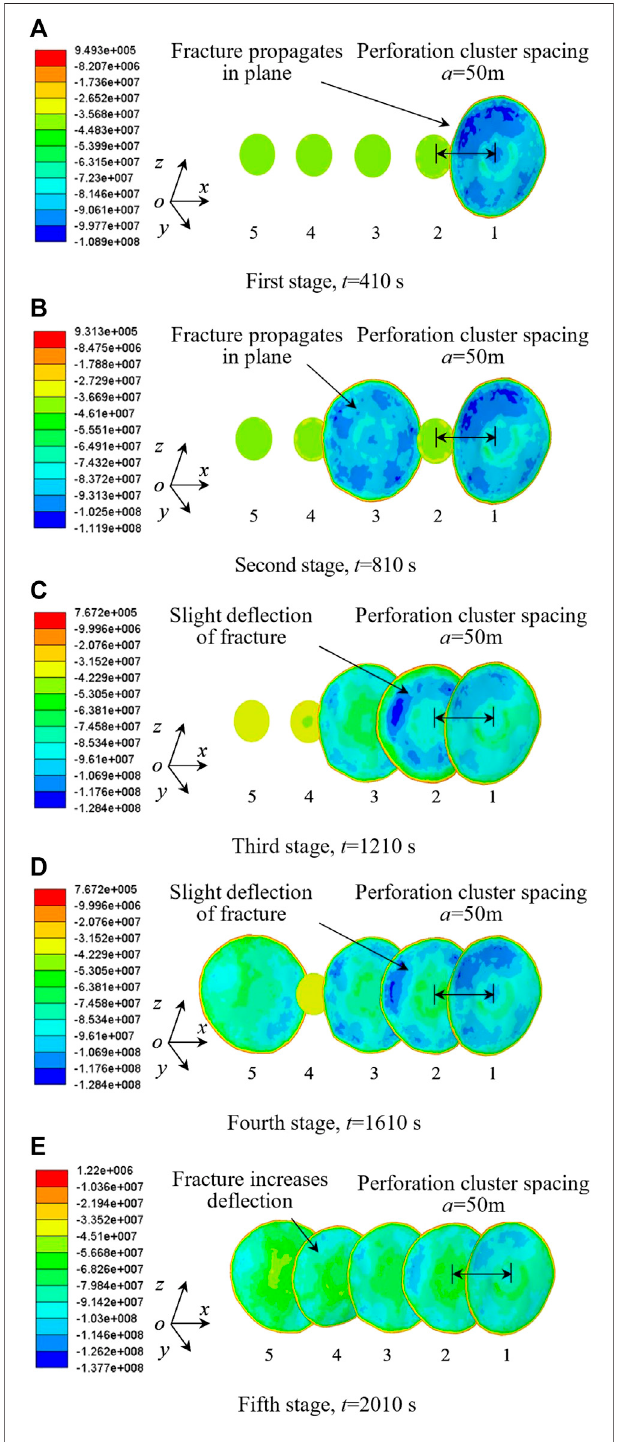
FIGURE 5 | Dynamic propagation of fracture network in alternate fracturing.